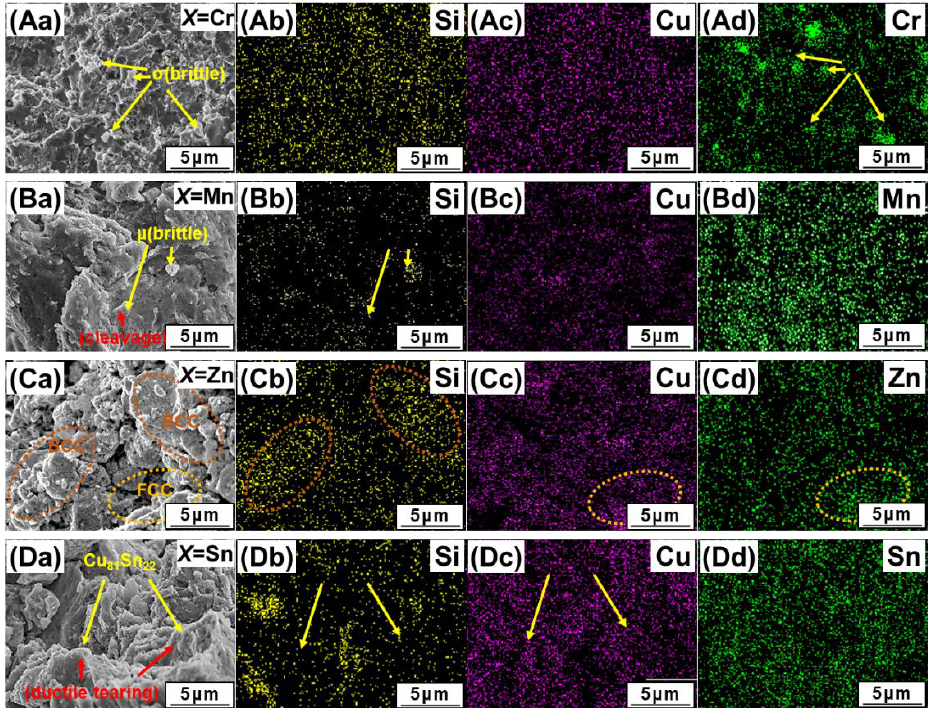
Figure 6. SEM-EDS study of the compressive fracture surfaces of ( Aa ) AlCuSiFeCr, ( Ba ) AlCuSiFeMn, ( Ca ) AlCuSiFeZn, ( Da ) AlCuSiFeSn HEAs. The corresponding EDS maps are shown in ( Ab – Ad , Bb – Bd , Cb – Cd , Db – Dd ).